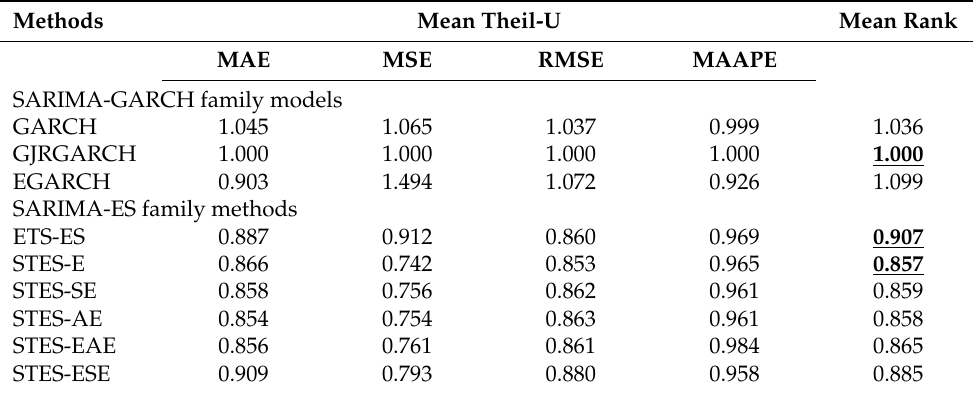
Table 10. Mean Theil-U of multiple evaluation criteria for best single method in